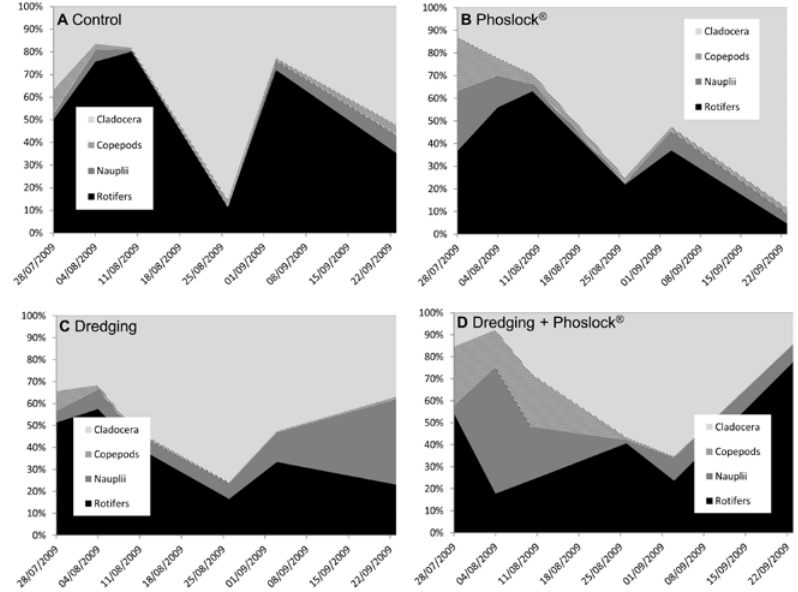
Figure A4. The relative abundances of major zooplankton groups (Cladocera, copepods, and their nauplli, rotifers) in control enclosures, Phoslock ® -treated enclosures, dredged enclosures, combination Phoslock ® -treated and dredged enclosures, and the pond over the 58-d experimental period in